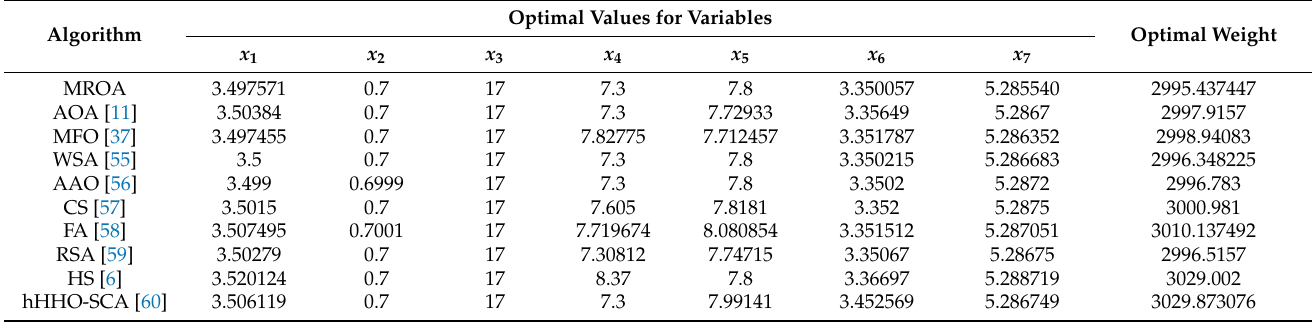
Table 14. Comparison of optimal solutions for the Speed Reducer Design